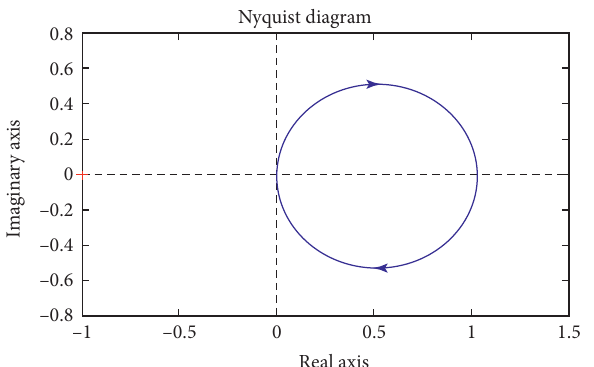
–0.5 Figure 6: The Nyquist